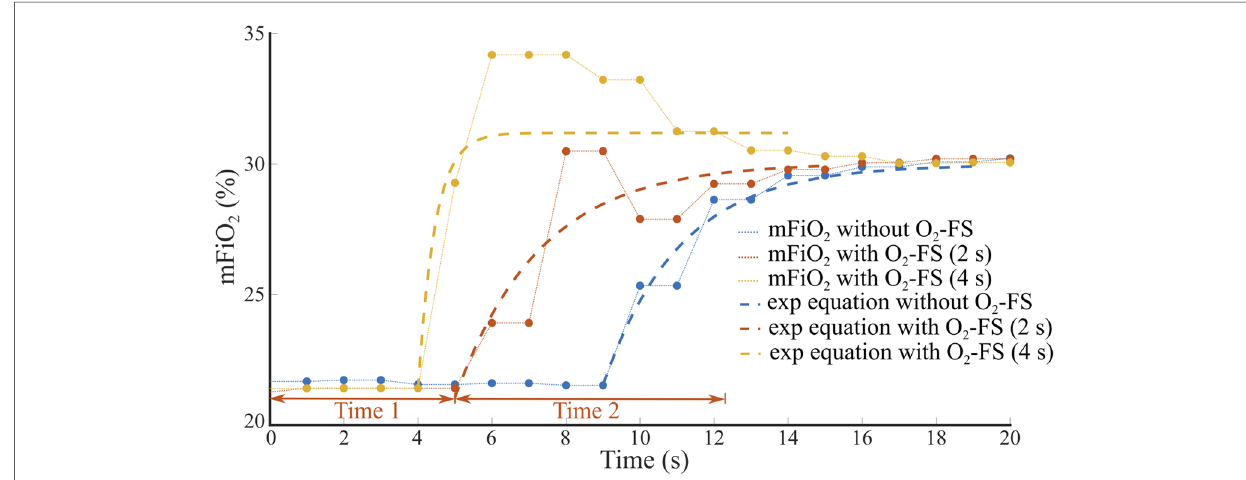
FIGURE 6 An example of the time delay of mFiO 2 increase after sFiO 2 change from 21% to 31%. Total time delay consists of the baseline delay (Time 1) and the duration of mFiO 2 rise (Time 2) that was approximated by an exponential function. The set fl ow rate on the CPAP ventilator was 8